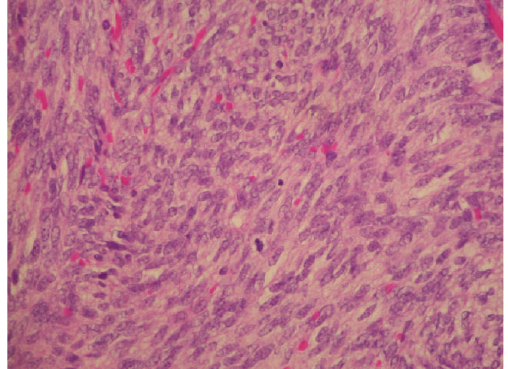
Figure 2: Microscopically, the tumour was composed of a dense proliferation of spindle cells, shaped cells with bland nuclei, and without no more mild cytological atypia. Note the presence of mitotic figures. Haematoxylin-eosin,